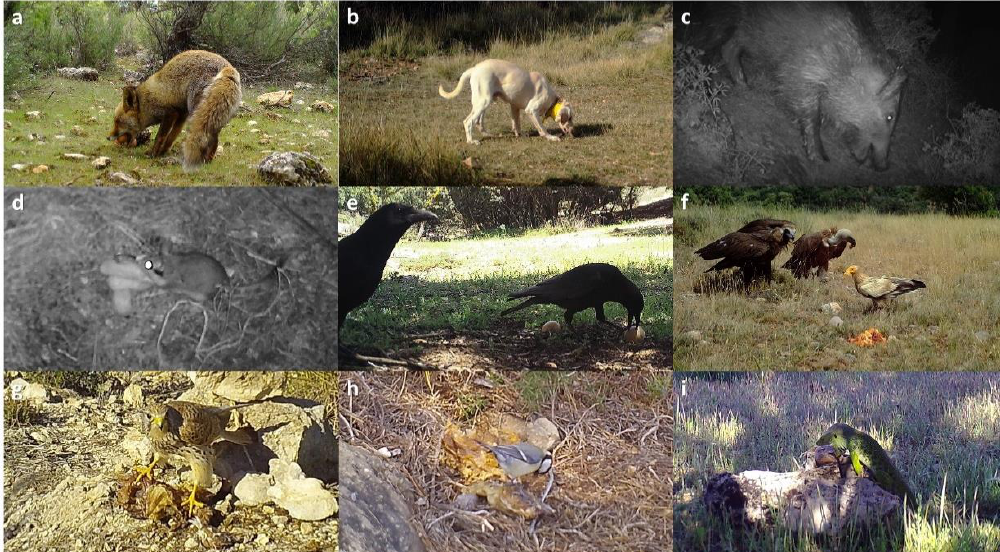
Figure 2. Individuals of the nine species groups feeding on experimental baits. ( a ). Wild carnivores, Vulpes vulpes . ( b ). Domestic carnivores, Canis lupus familiaris . ( c ). Suids, Sus scrofa . ( d ). Small mammals, Eliomys quercinus . ( e ). Corvids, Corvus corone . ( f ). Vultures, Aegypius monachus , Gyps fulvus and Neophron percnopterus . ( g ). Other raptors, Falco tinnunculus . ( h ). Other birds, Parus major . ( i ). Reptiles, Timon lepidus .